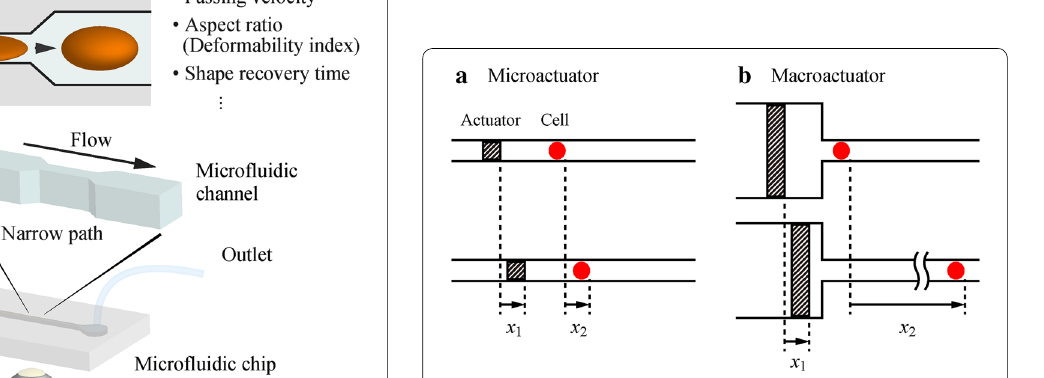
Fig. 3 Two types of actuators for driving microfluidic flow. a Microactuator. b Macroactuator. The hatched parts represent the